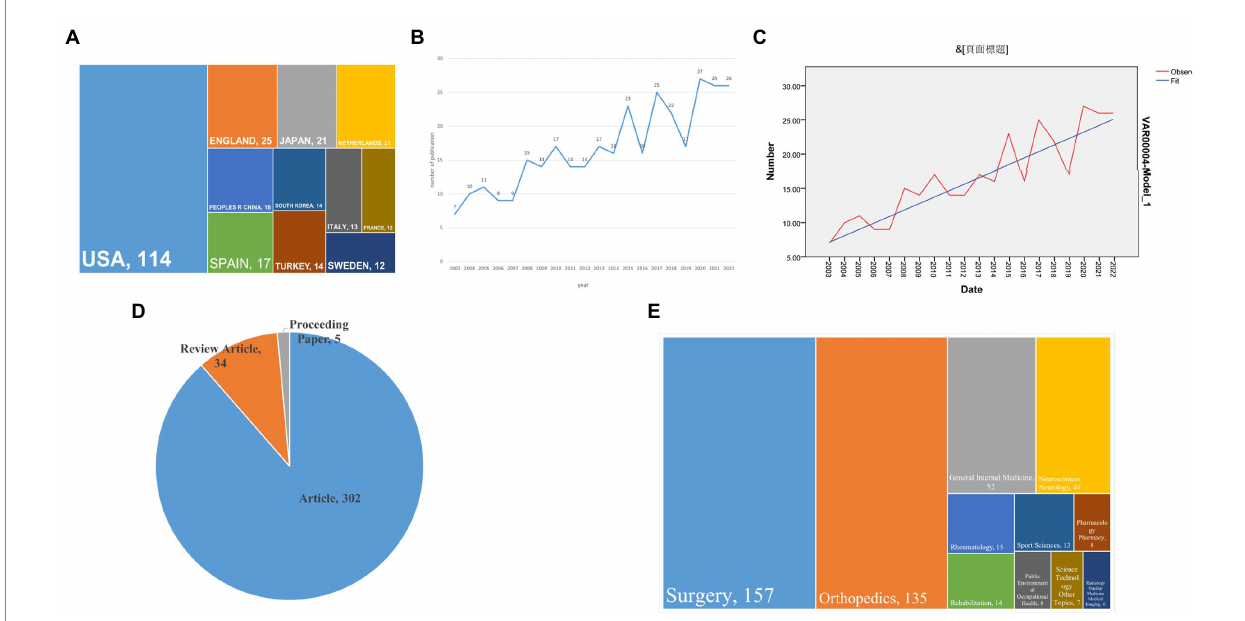
FIGURE 1 Global characteristics in the surgical treatment of CTS. (A) Volume of publications on surgical treatment of CTS by country and region from 2003 to 2022. (B) Annual volume of publications on surgical treatment CTS from 2003 to 2022. (C) Future publication forecast curve. (D) Article-genre breakdown on surgical treatment of carpal tunnel syndrome from 2003 to 2022. (E) WoS catalog classification of research